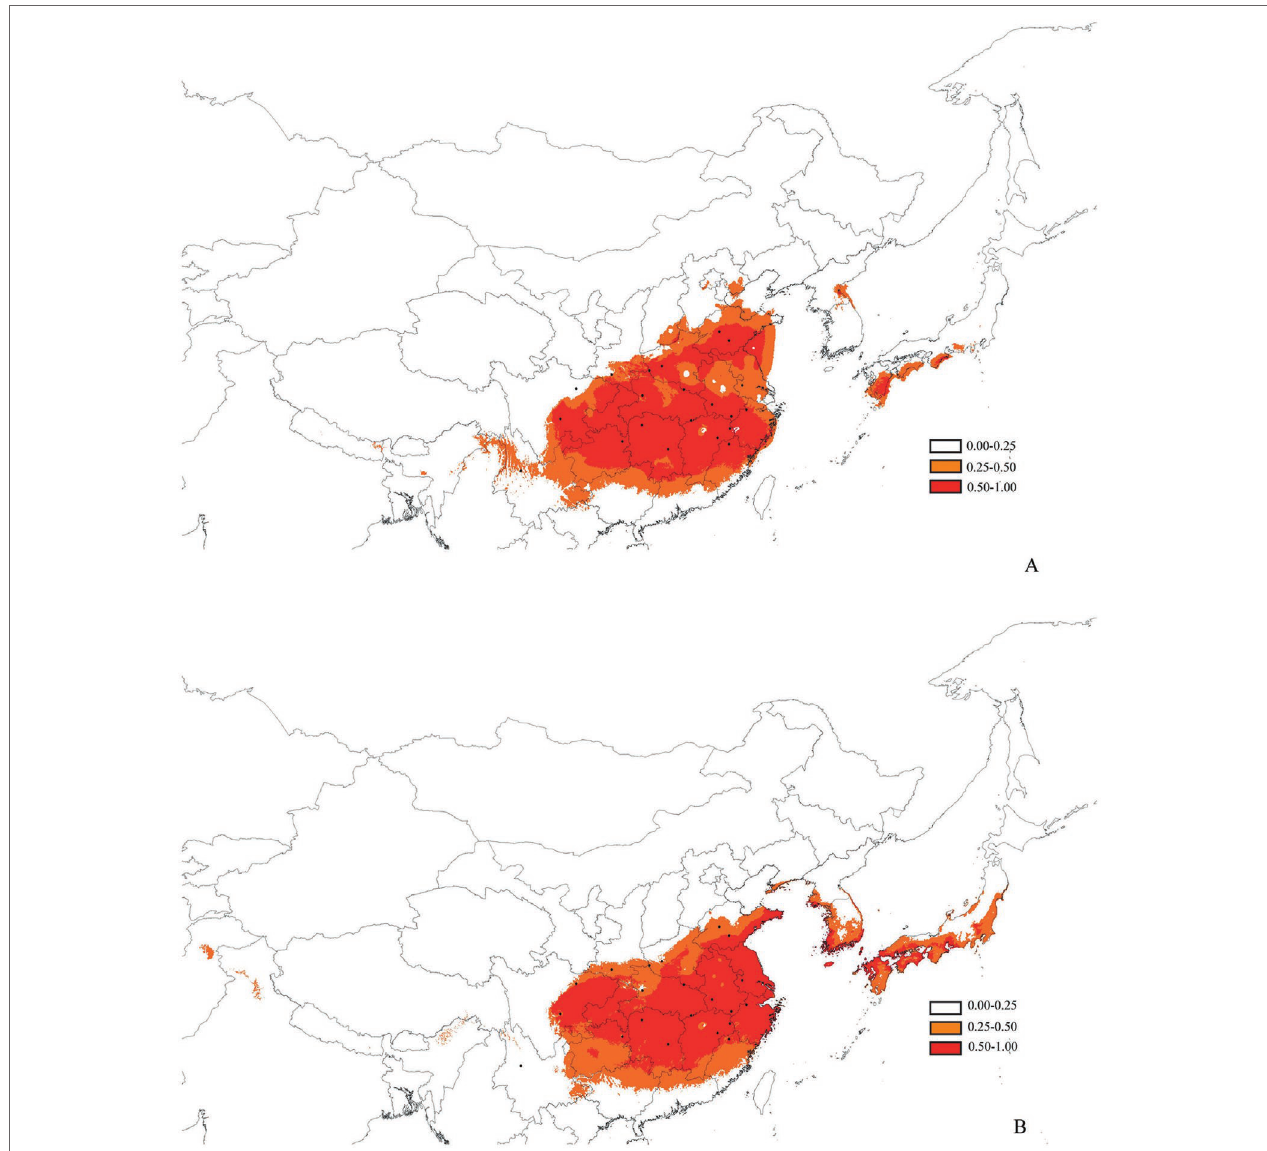
FIGURe 7 | Maps showing potential distribution as a probability of ecological niche modeling with Maxent, distribution maps of Pterocarya stenoptera were yielded by software DIVA-GIS. (Light red, logistic value 0–0.25; Dark red, logistic value 0.5–1). (A) The Last Glacial Maximum, about 21 thousand years ago, (B) the present.